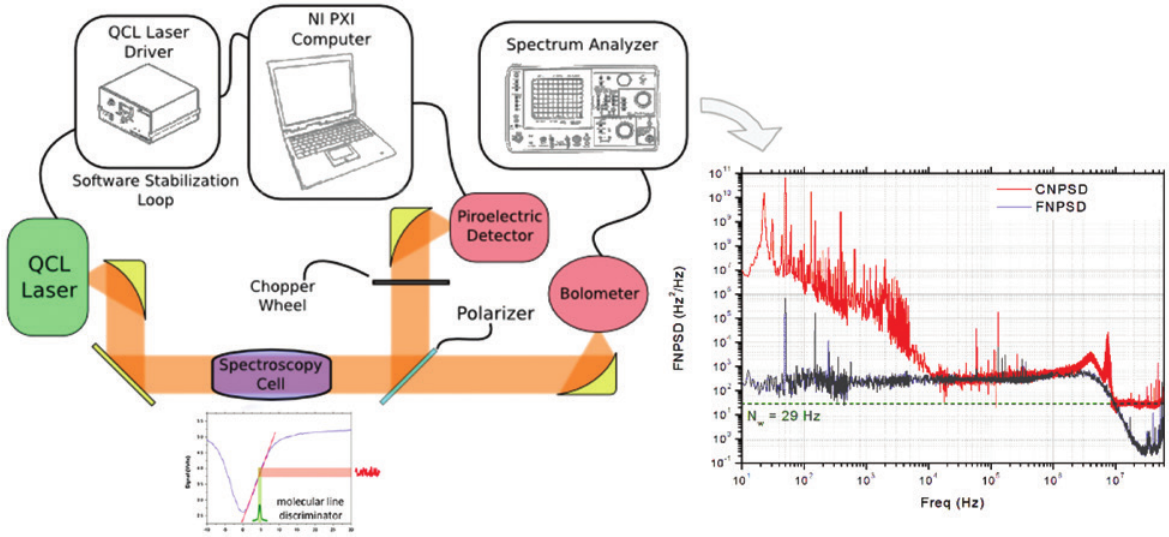
Figure 13: FNPSD of a THz QCL. Left: Schematic diagram of the experimental setup, using a molecular transition as frequency-to-amplitude discriminator. Right: experimental FNPSD of the THz QCL (red trace), compared with the contribution to frequency noise of the CNPSD of the current driver (black trace). The dashed green line marks the white noise level. Reprinted with permission from [127], copyright